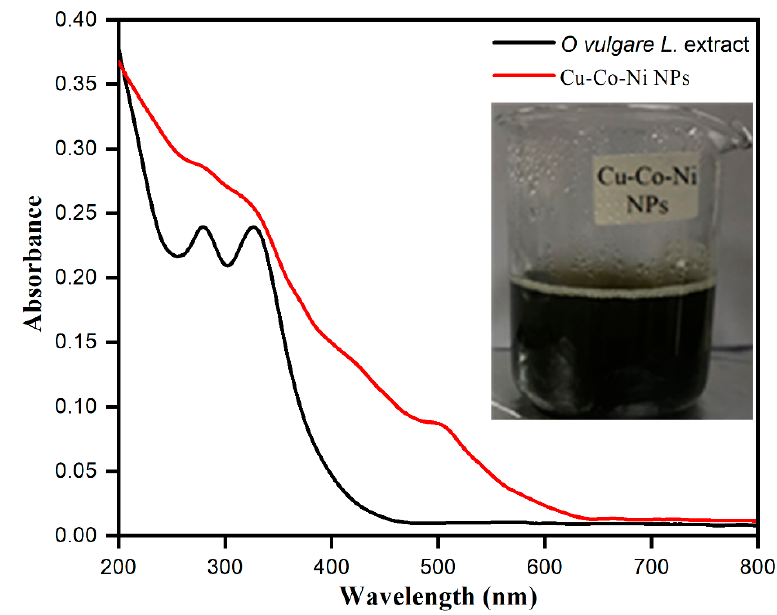
Figure 3. Ultraviolet (UV)–visible spectra of Origanum vulgare L. extract and biosynthesized Cu-Co-Ni trimetallic nanoparticles.